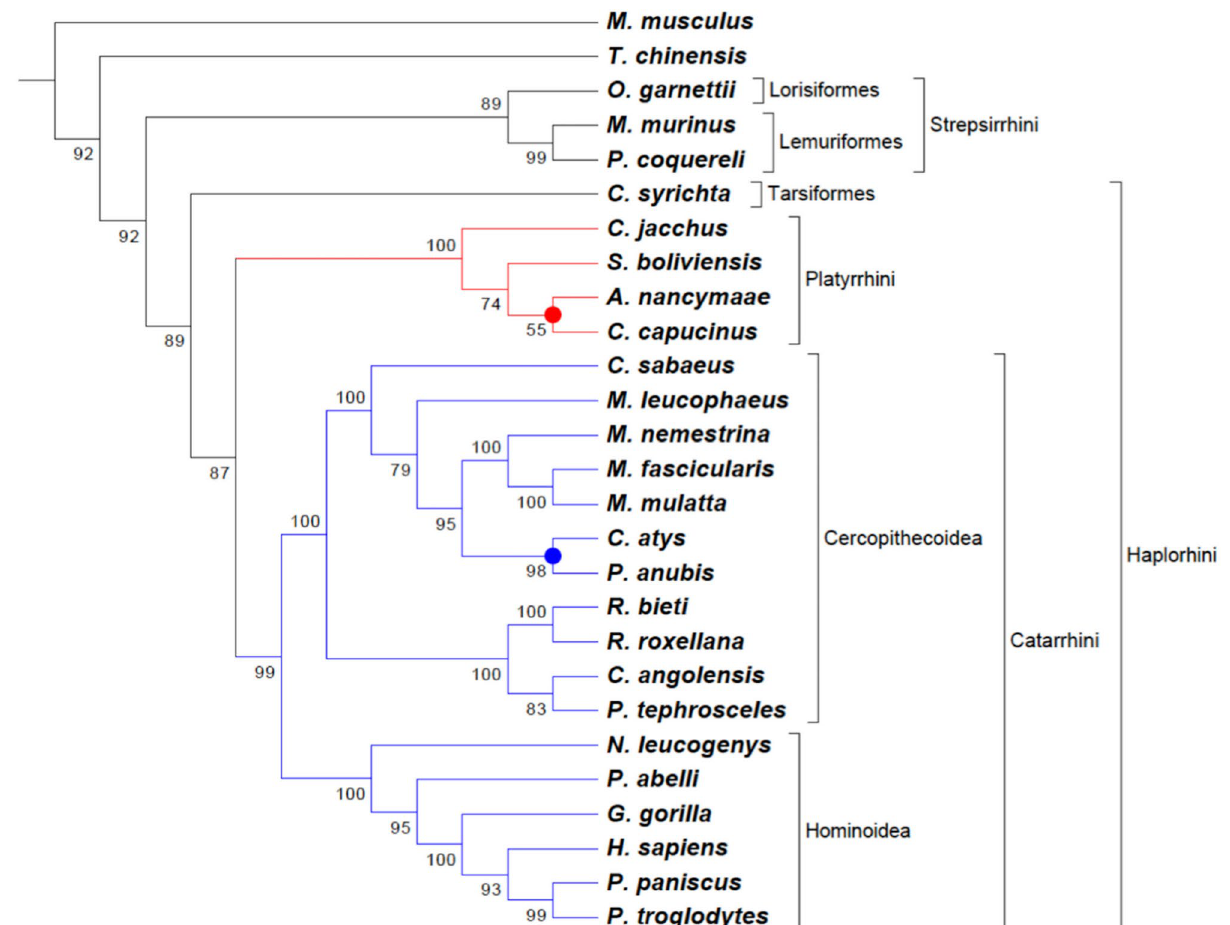
Figure 4. Phylogenomic tree of Primates. Phylogram constructed with the TOMM approach using approximately 23,826 orthologous protein pairs across 25 Primates species with genome sequence available (Table 3 and Supplemental Table S3), and two outgroup species. Numbers next to the branches represent the percentages of approximate unbiased support probabilities for 10,000 bootstraps, calculated using the pvclust 82 package in R (R Core Team. R: A language and environment for statistical computing. R Foundation for Statistical Computing, Vienna, Austria, 2018, URL: https ://www.R-proje ct.org/). The Newick file was annotated using the program MEGA